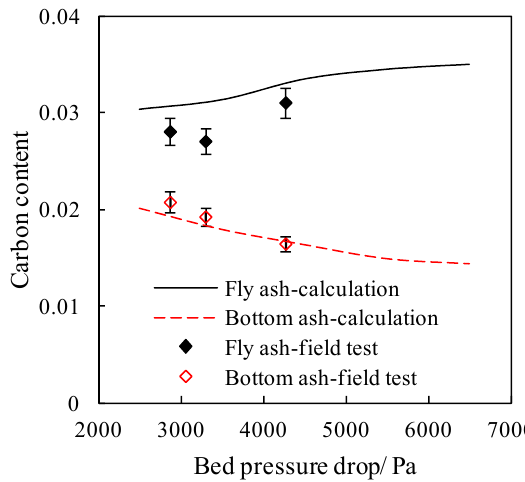
Figure 4. Effect of bed pressure drop on the carbon content.